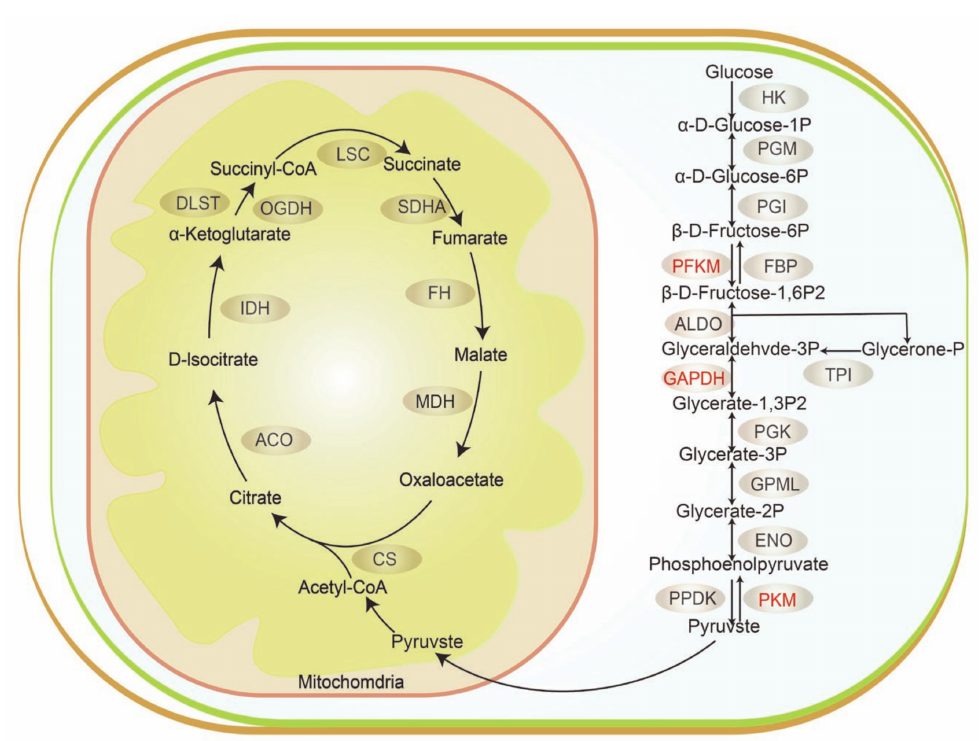
Figure 6. DEPs are involved in the glycolytic process. The three down-regulated DEPs (PFKM, GAPDH, and PKM) are labeled in red.